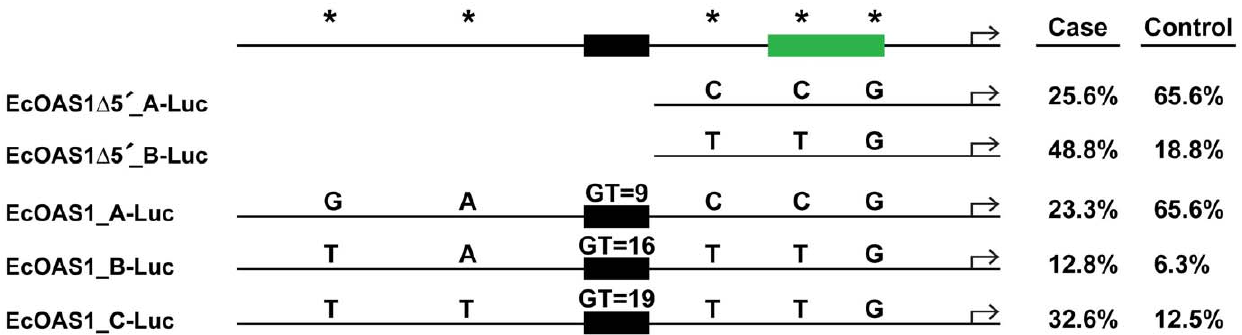
Figure 1. OAS1 -Luciferase expression constructs, genotypes and population frequency. Schematic diagram of the OAS1 promoter constructs expressing the luciferase reporter coding region. The interferon stimulated response element (green) is shown from sequence alignments between horse and human OAS1 promoters. The previously identified dinucleotide microsatellite (black) is shown with corresponding repeat length. Deletion constructs EcOAS1 D 5 9 _A-Luc and EcOAS1 D 5 9 _B-Luc do not contain the microsatellite repeat and upstream sequence. TagSNPs(*) ss104806918, ss104806922, ss104806924, ss104806926, ss104806927 and genotypes are shown for each construct. Case and control haplotype frequencies represented by each clone are also shown.